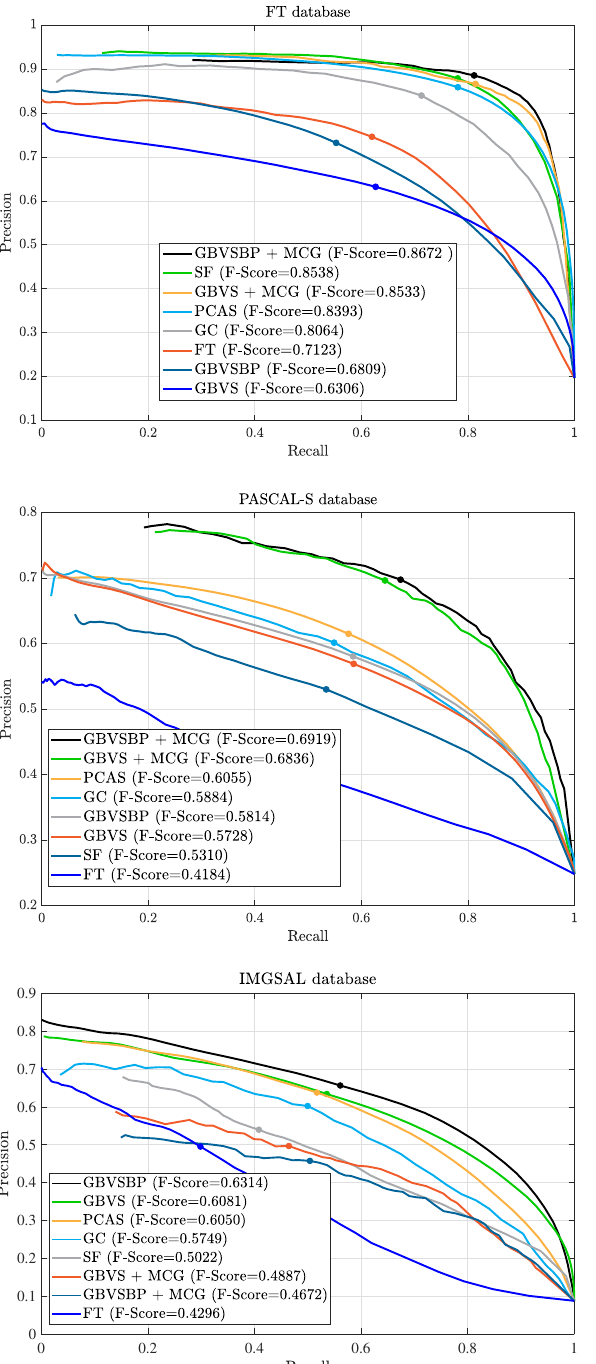
Figure 3. The precision–recall curve for FT, PASCAL-S, and IMGSAL datasets using the following algorithms: GBVSBP + MCG, SF, GBVS + MCG, PCAS, GC, FT, GBVSBP, and